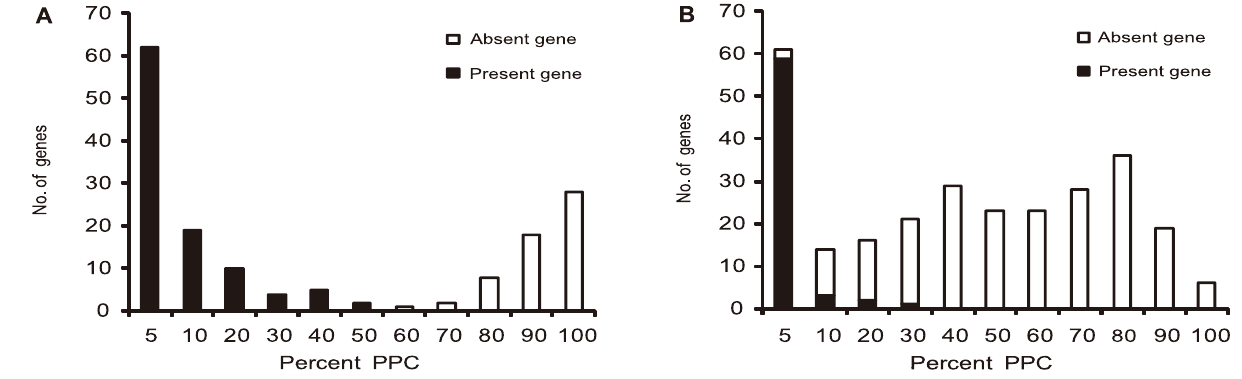
Figure 2. Distribution of percentage positive calls (PPC) for determination of cut-off values of calling a gene present or absent. (A) Histogram for P1/7 PPC values. (B) Histogram for 89-1591 PPC values. The actual presence (black-coded) or absence (white-coded) of a gene was determined by genome comparison between P1/7 (A) and 89-1591 (B) with GZ1 respectively. The cutoff PPC value minimizes the number of genes present being called absent.